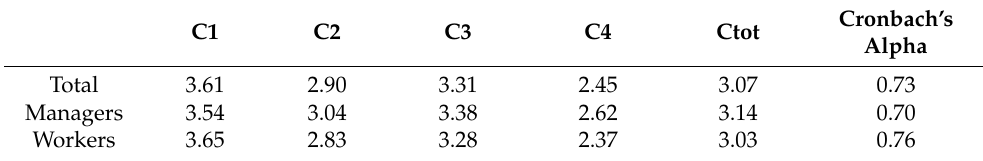
Table 7. Results of the COVID-19 questionnaire 1 .